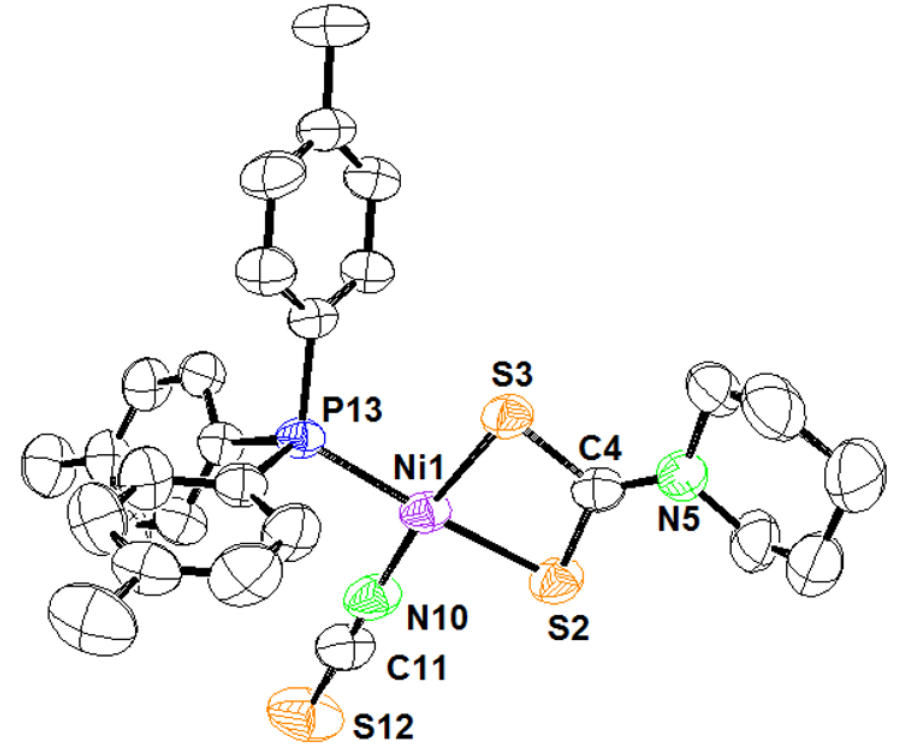
Figure 3. ORTEP of [Ni(pipdtc)(4-MP)(NCS)] (1) (Hydrogens are excluded; Ellipses are of 50% probability).